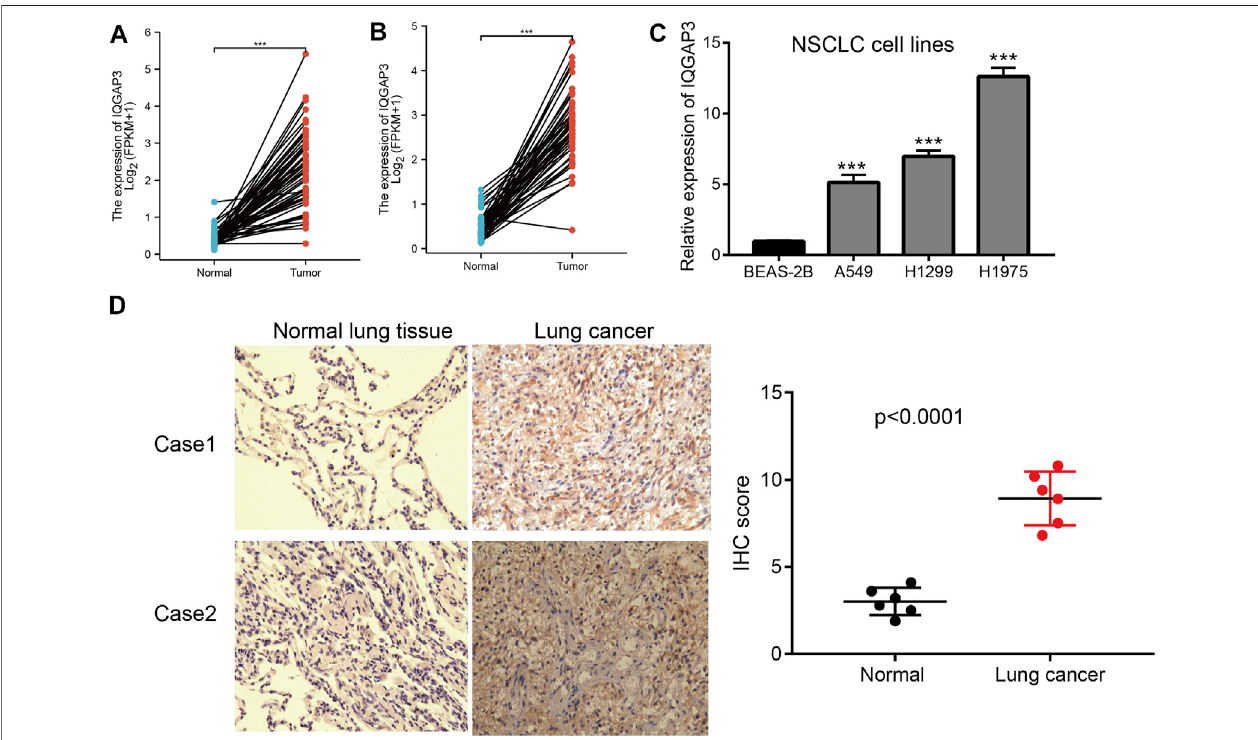
FIGURE 13 | Analysis of the expression of IQGAP3 expression in NSCLC. (A) The expression of IQGAP3 in LUAD was examined by using the TCGA LUAD database. (B) The expression of IQGAP3 in LUAD was examined by using the TCGA LUAD database. (C) The expression of IQGAP3 in NSCLC cell lines was examined by using the qRT-PCR assay. (D) The expression of IQGAP3 in lung cancer was examined by using an IHC